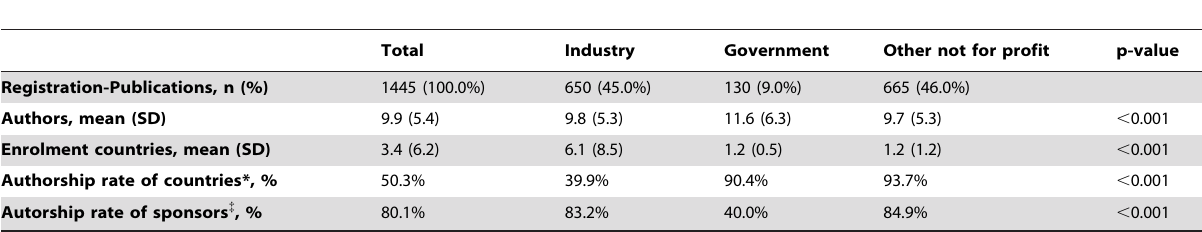
Table 1. Number of authors and authorship rates of sponsors and